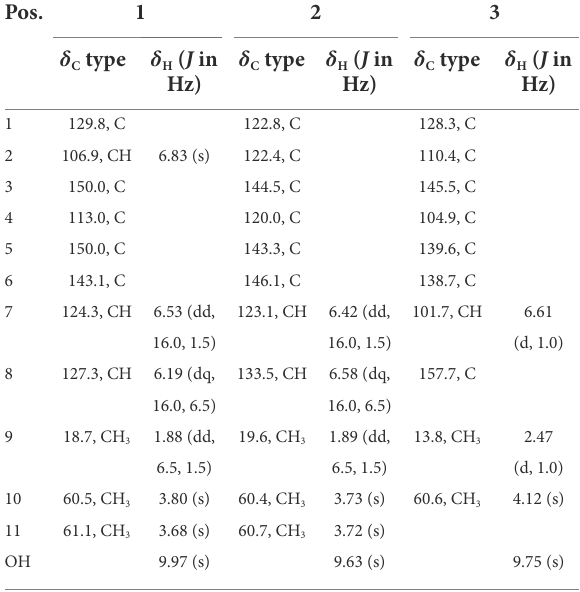
TABLE 1 1 H (500 MHz) and 13 C (125 MHz) NMR data for 1 – 3 ( δ in ppm, DMSO-